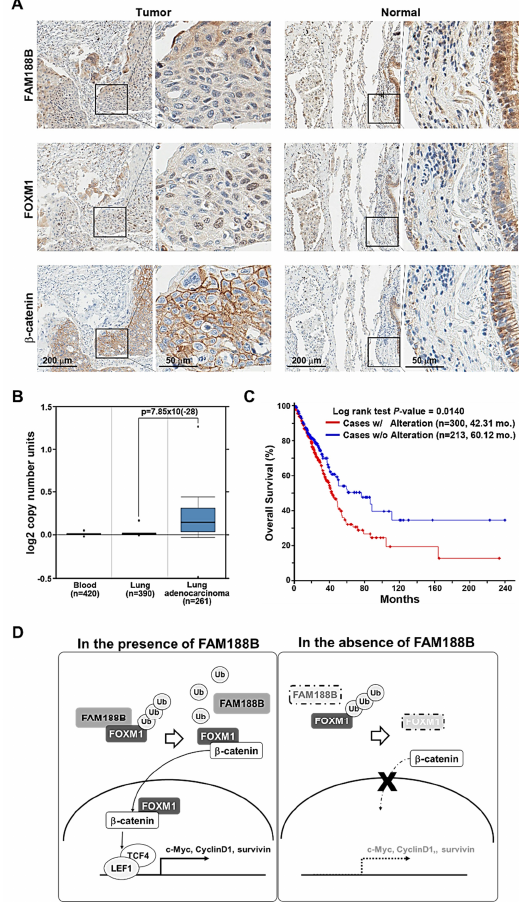
Figure 7. Clinical relevance of FAM188B expression in lung adenocarcinoma patients and a proposed model for an oncogenic role of FAM188B via FOXM1 regulation. ( A ) Immunohistochemical analysis of levels of FAM188B, FOXM1, and β -catenin in lung cancer tissues and normal lung tissues. Images of in each set were taken at 10 × (left panel, scale bar; 200 µ m) and boxed areas were magnified at 40 × (right panel, scale bar; 50 µ m). ( B ) Oncomine survey of significantly different copy number unit number between normal vs. cancer in TCGA lung 2 ( p = 7.85 × 10 − 28 ). ( C ) Overall survival curves for lung cancer patients with (red line) or without (blue line) FAM188B alteration from TCGA Firehose LUAD ( n = 586) dataset ( p = 0.0140). ( D ) Schematic proposed model of FAM188B in association with FOXM1